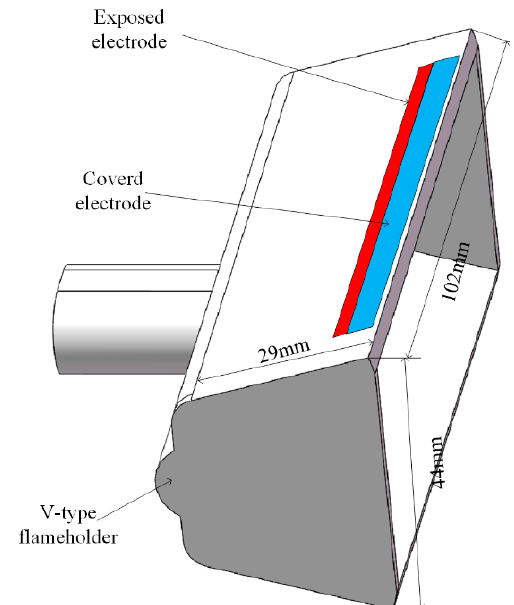
Figure 3. Schematic diagram of the flame-holder model.